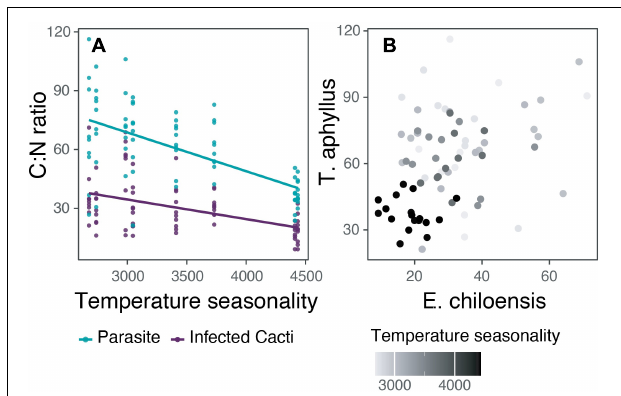
FIGURE 5 | The relation of C:N ratio of the holoparasite Tristerix aphyllus with its host Echinopsis chiloensis and temperature seasonality. (A) Linear relation of temperature seasonality with C:N ratio differentiating between the parasite and infected cacti nutrient content (for the parasite: R 2 = 0.35, p < 0.001). (B) C:N ratio for each sampled holoparasite compared with its particular